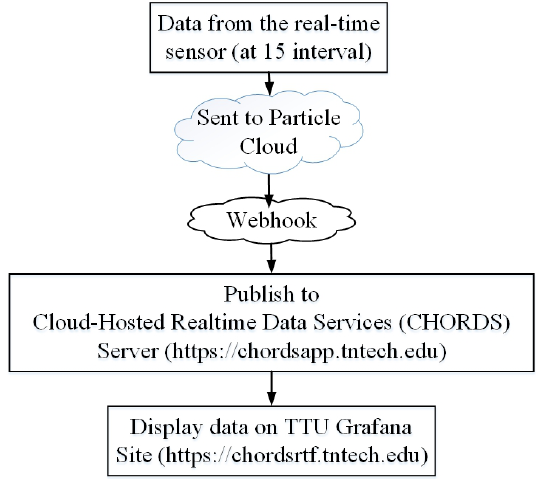
Figure 5. Components of the water level sensor.